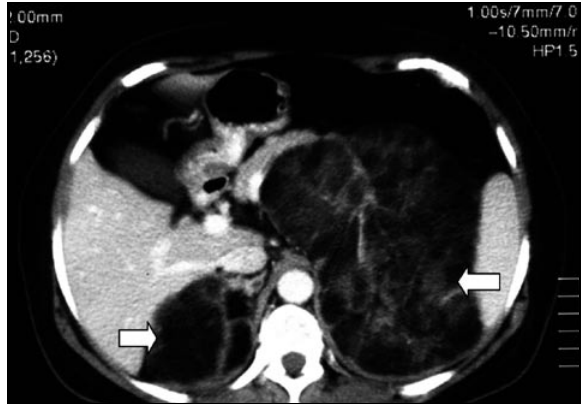
Figura 1 – Tomografia computadorizada de abdome mostrando massas bilaterais de densidade mista com predomínio de gordura (setas)